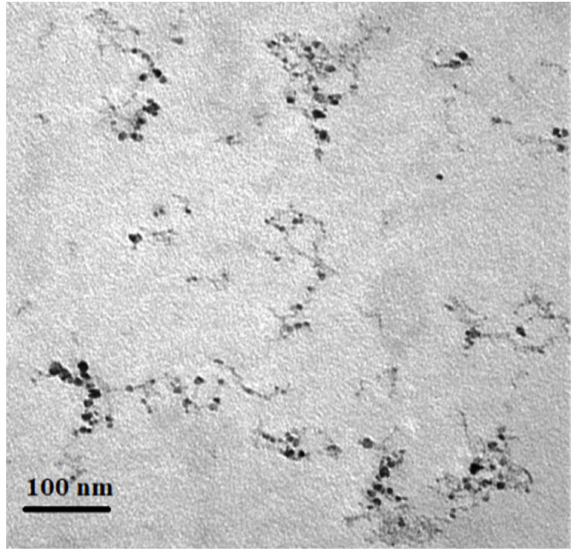
Figure 8. TEM image of TiO 2 nanoparticles.